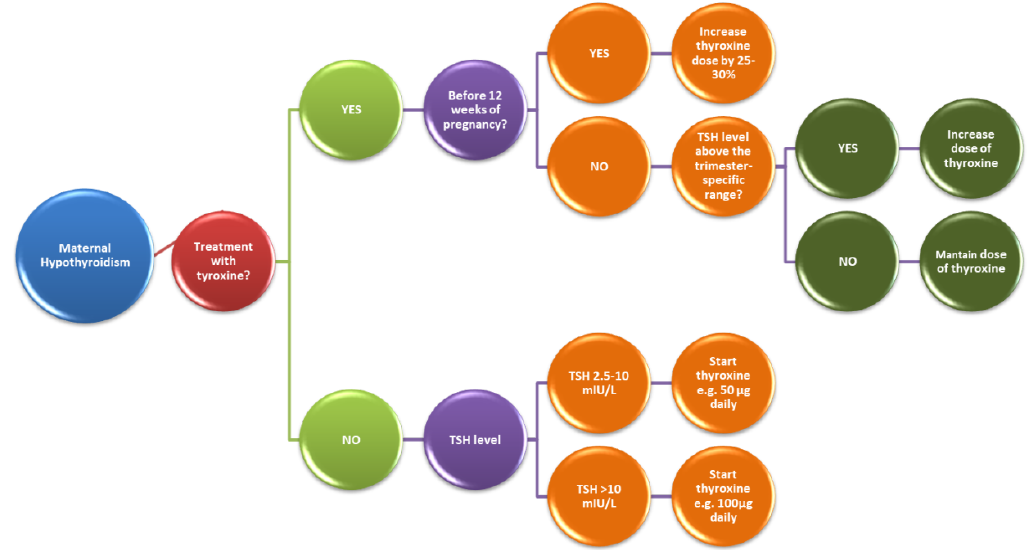
Figure 3. Pharmacotherapeutic management in maternal hypothyroidism.